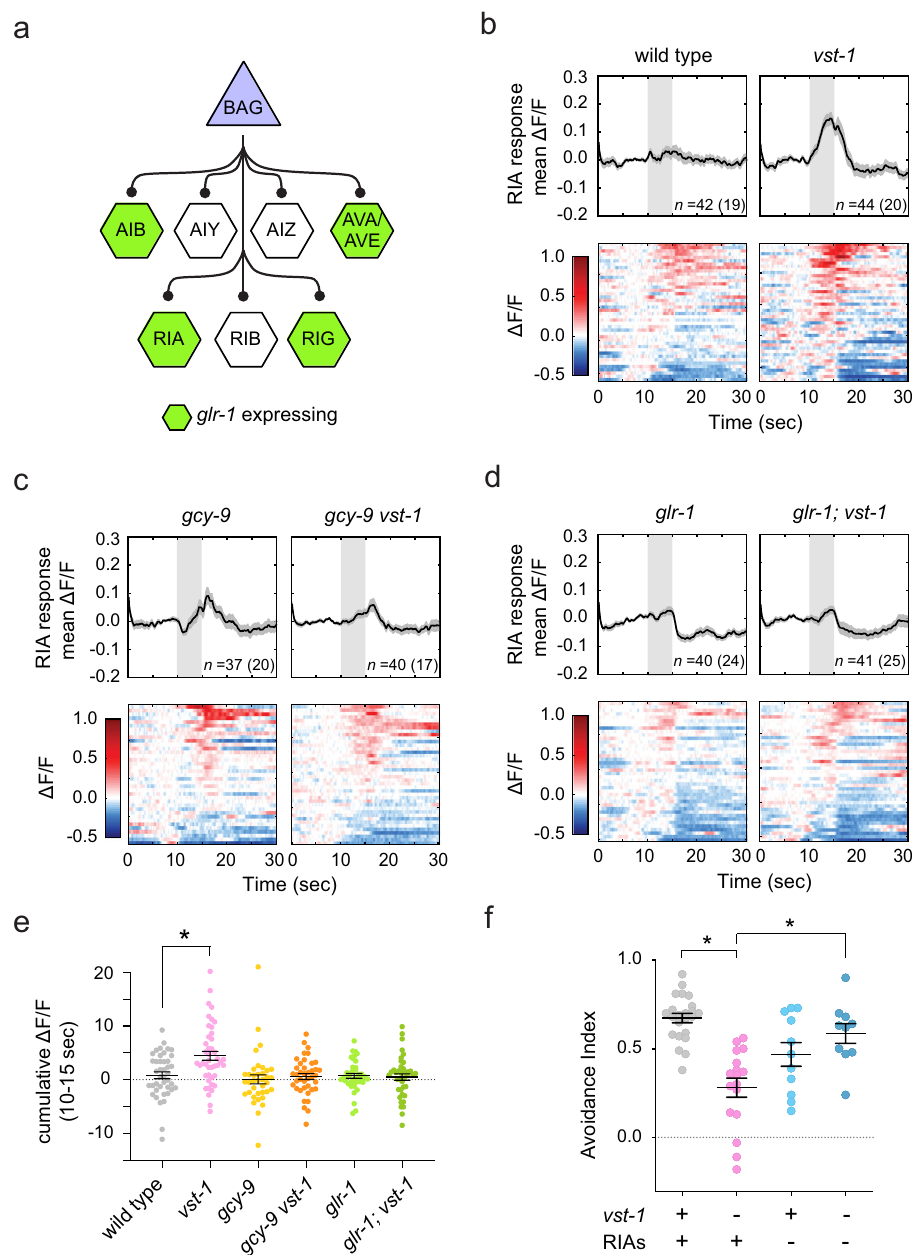
Fig. 6 Loss of VST-1 alters the chemotaxis circuit downstream of BAGs by engaging RIA interneurons. a A schematic showing interneurons that receive synaptic input from BAG sensory neurons. b – d GCaMP signal ( Δ F / F ) measured in RIA neurons ( Pglr-3a::GCaMP3 ) during stimulation of BAGs with 10% CO 2 stimuli. Upper panels show the mean signal ± SEM as black lines and gray shaded regions, respectively. Individual traces were passed through a 0.5 s moving-average fi lter for the plots (raw traces were used for quanti fi cation of GCaMP signal in e ). Lower panels show individual responses as colormaps. The number in parentheses indicates the number of worms analyzed and n indicates the total number of cells analyzed. e Summary data from experiments shown in b – d . The dot plots show cumulative GCaMP signal (mean ± SEM) during CO 2 presentation (10 – 15 s) of the indicated genotypes. * P < 0.05 determined by a Kruskal – Wallis test and corrected for multiple comparisons between wild type and other genotypes via Dunn ’ s test ( P -value for wild type vs. vst-1 : 0.017). f Effects of RIA ablation on CO 2 chemotaxis of the wild type and vst-1 mutants. The mean ± SEM of avoidance indices for each condition are indicated ( n = 23, 17, 11, and 10 for wild type, vst-1 , RIA ablation in wild-type background, and RIA ablation in vst-1 mutants, respectively). * P < 0.05 determined by a Kruskal – Wallis test and corrected for multiple comparisons between vst-1 mutants and other genotypes via Dunn ’ s test ( P -values for each comparison — vst-1 vs. wild type: 8.7 × 10 − 7 ; vst-1 vs. RIA ablation in wild-type background: 0.17; vst-1 vs. RIA ablation in vst-1 mutants: 0.014). GCY-9 in vst-1 mutants suppressed the effect of vst-1 mutation, there was no clear effect of vst-1 mutation (Fig. 6d, e), indicating suggesting the BAG CO 2 -sensing machinery is required for its that the increased activation of RIAs observed in vst-1 mutants effect (Fig. 6c, e). We further tested whether the effects of vst-1 requires signaling through GLR-1. mutation on RIA activation by BAGs require GLR-1 glutamate To determine whether increased activation of RIA contributes receptors, as predicted by our model. In mutants lacking GLR-1, to the chemotaxis defects of vst-1 mutants, we tested the effect of NATURE COMMUNICATIONS| (2021) 12:6334